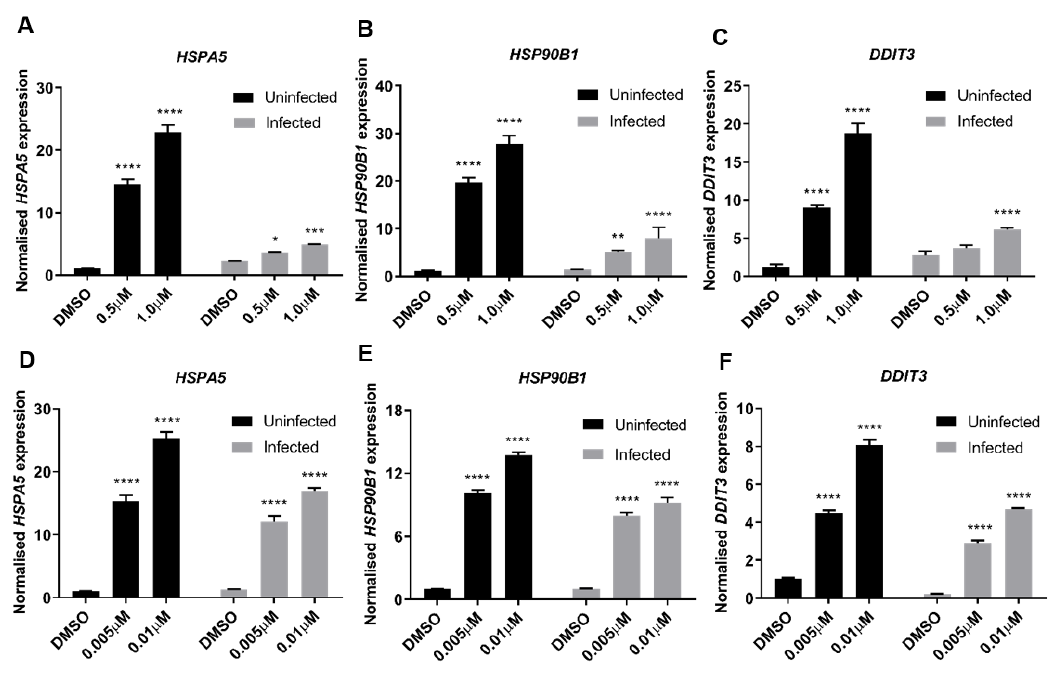
Figure 7. ER stress is a driver of host antiviral response to TG priming. ( A – C ) NPTr cells or ( D – F ) NHBE cells were primed with DMSO or TG for 30 min at the indicated concentrations and infected for 24 h with USSR H1N1 virus at 0.5 MOI. Total RNA was extracted from each sample for HSPA5, HSP90B1 and DDIT3 detection, normalised to 18S rRNA. Indicated significance based 2-way RM ANOVA relative to corresponding DMSO control. * p < 0.05 ** p < 0.01, *** p < 0.001 **** p < 0.0001.